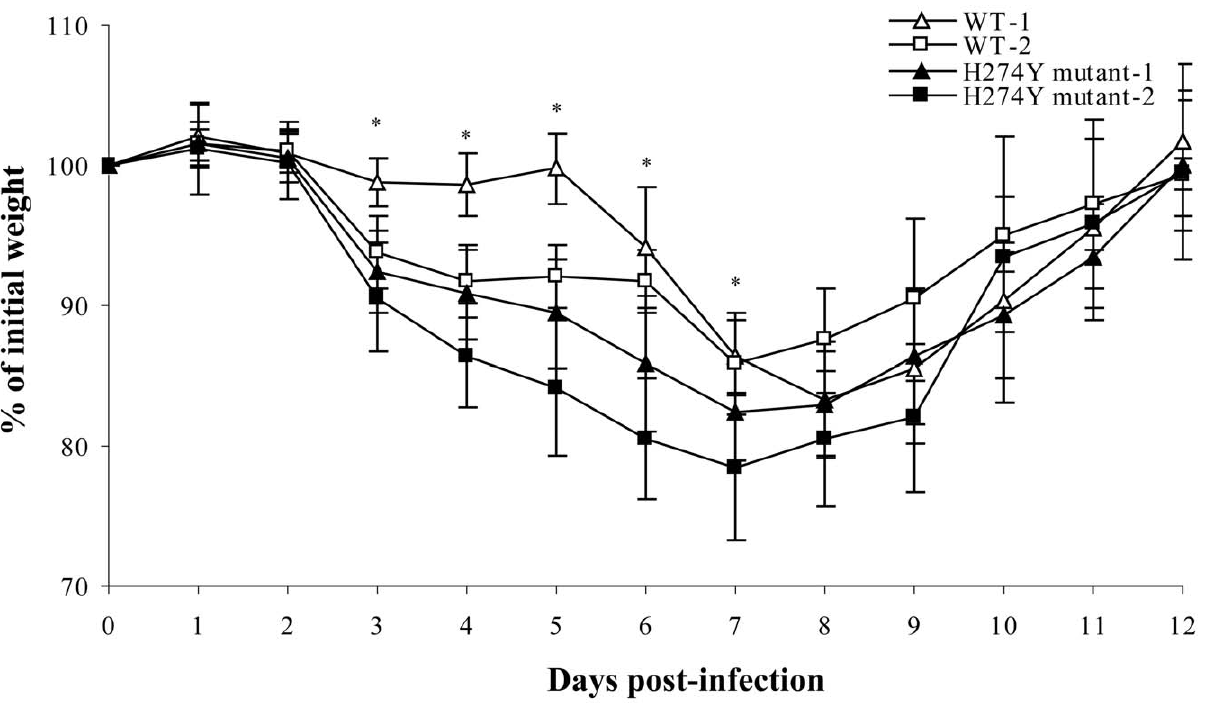
Figure 2. Weight loss of mice infected with wild-type (WT) or H274Y mutant isolates of pH1N1. The weight loss of mice was evaluated in two groups of 15 mice (infected with the WT and H274Y mutant isolate) over a period of 14 days. These experiments were performed twice and reported as # 1 and # 2 on the graph. * P , 0.05 between the WT and H274Y pH1N1 weight losses.